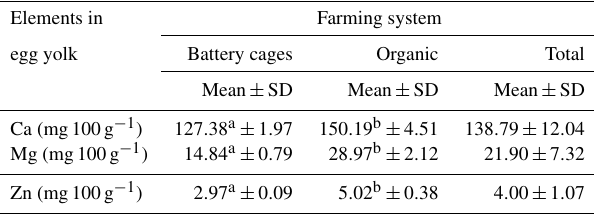
Table 2. Content of Ca, Mg and Zn in egg white depending on the farming system.